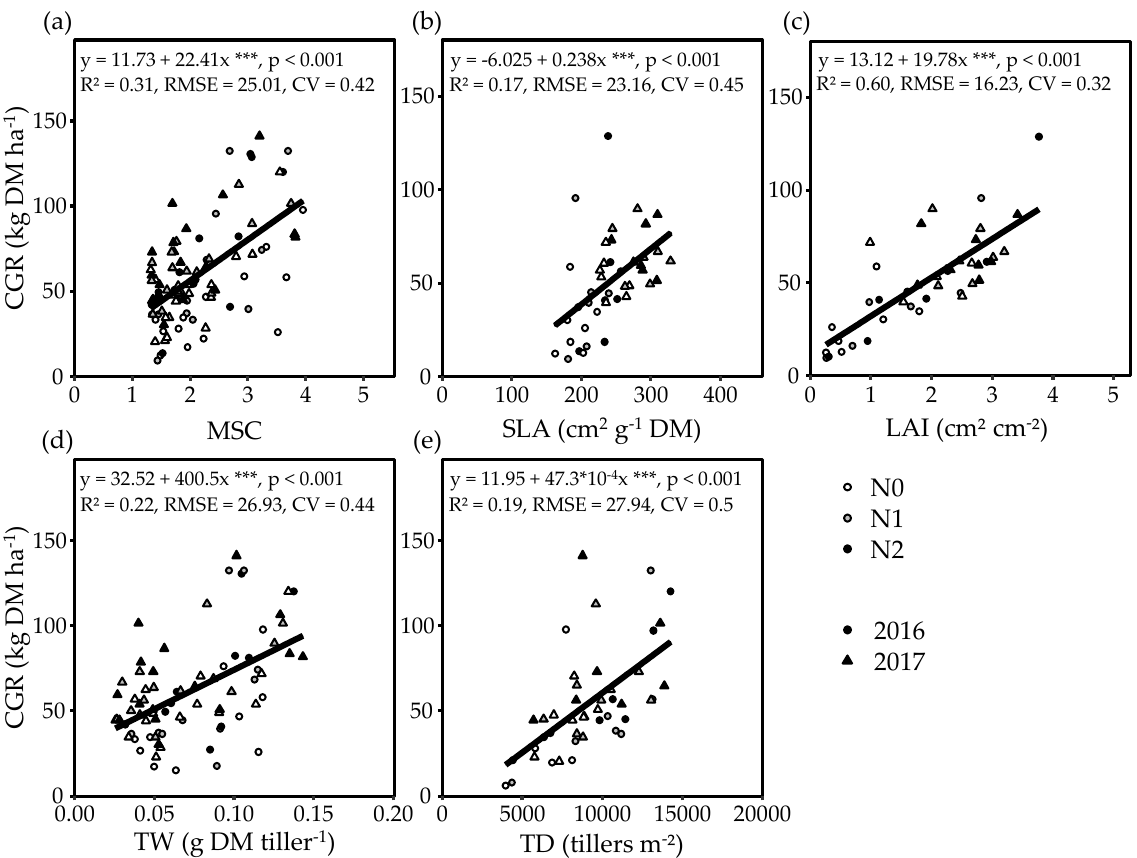
Figure 6. Linear relationships between crop growth rate (CGR) and ( a ) mean stage by count (MSC), ( b ) specific leaf area (SLA), ( c ) leaf area index (LAI), ( d ) tiller weight (TW) and ( e ) tiller density (TD) for three N application rates (0 (N0), 140 (N1) and 280 (N2) kg N ha − 1 ) across two years (2016 and 2017).